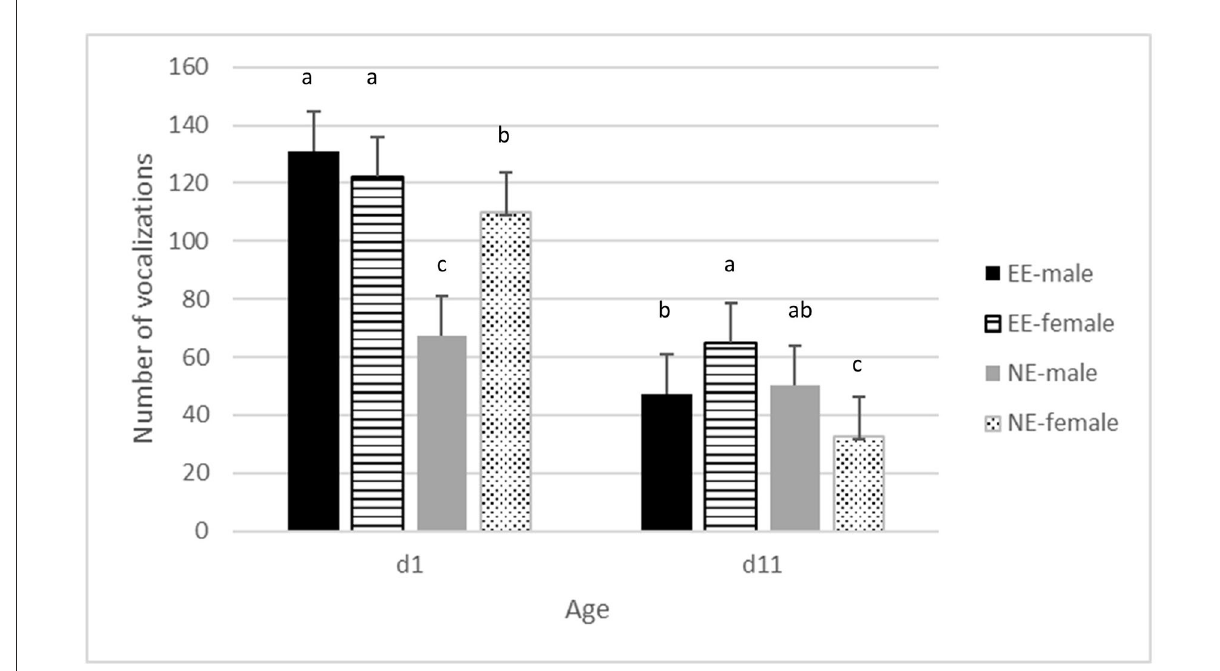
FIGURE1 Average frequency of vocalizations ± se in the novel environment test on days 1 and 11 of age, for males and females in pens without a brooder (NE) and with a dark brooder until day 14 of age (EE). Bars lacking a common letter differ significantly ( P < 0.05).